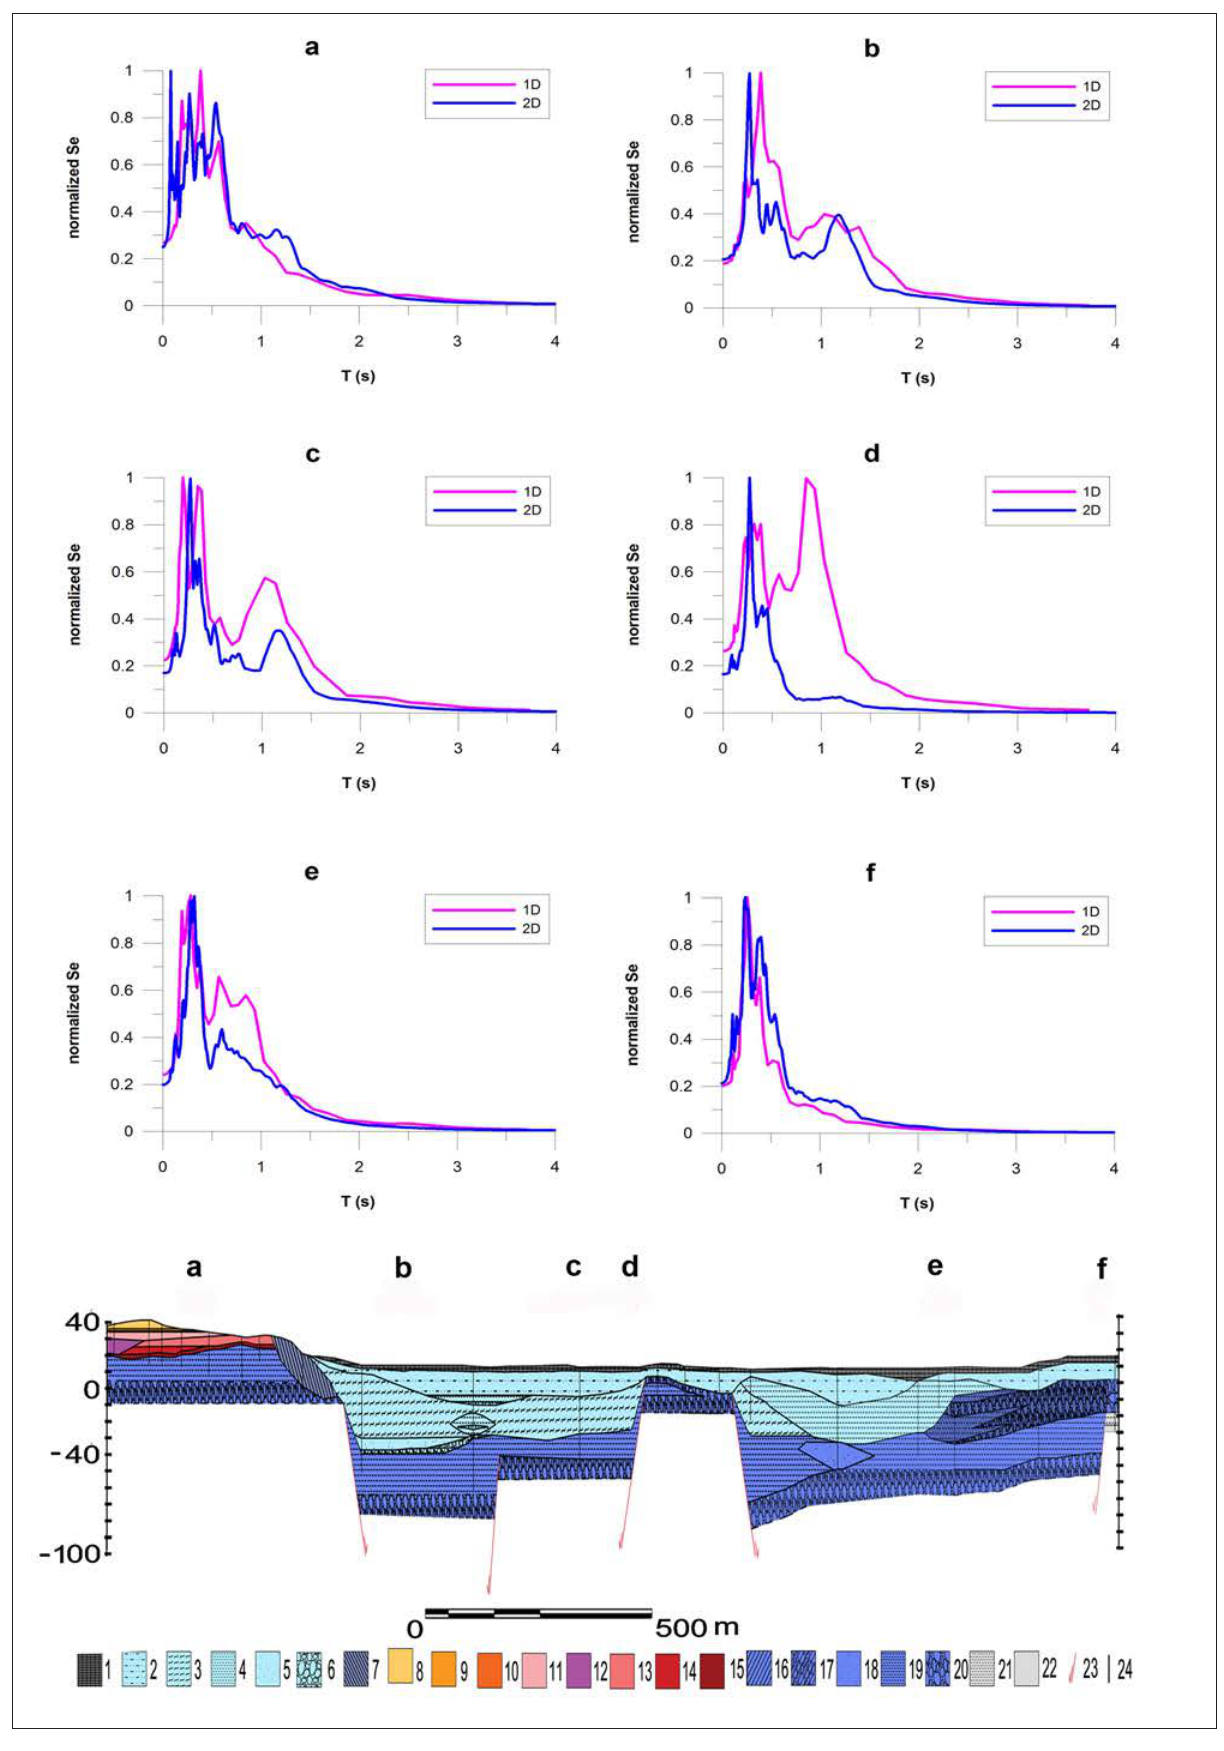
Figure 16. Comparison between 1D and 2D normalized response spectra in different position along the ancient route of Via Laurentina (bottom). See Figure 4 for the key to the